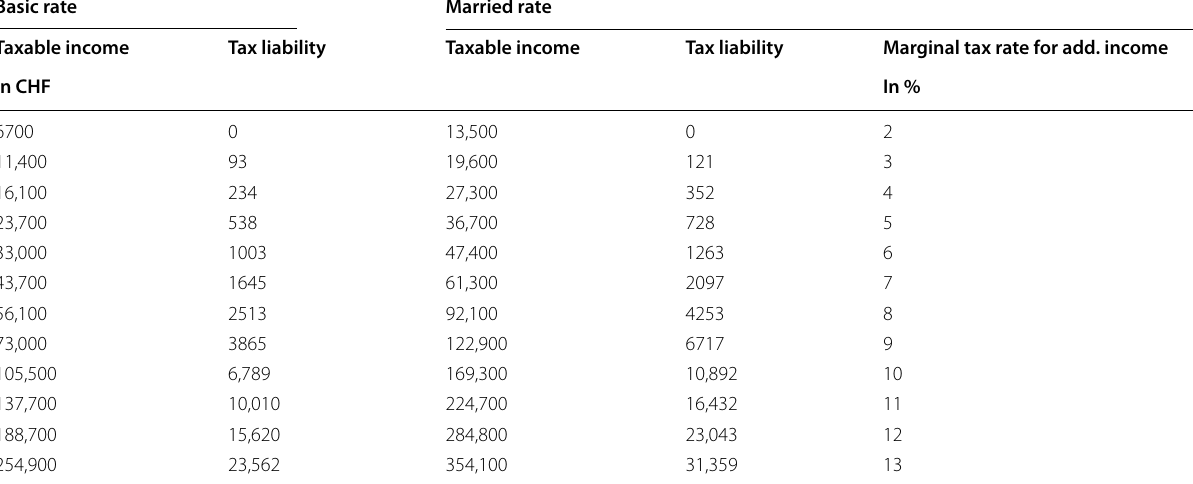
Table 1 Income tax scheme for the canton of Zurich (2014) Basic